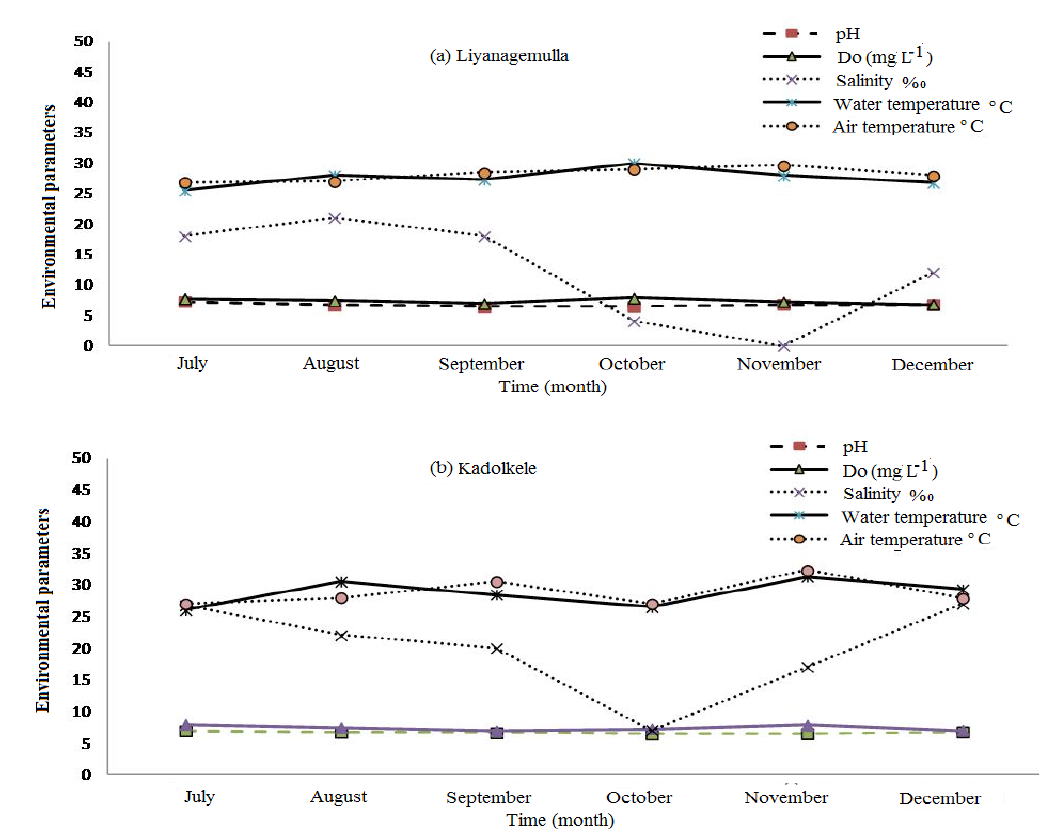
Figure 4: Monthly variation of environmental parameters, in study sites, (a) Liyanagemulla (b) Kadolkele. Table 6: Pearsons correlation coefficients (r) between mysid abundance and environmental Parameters. Water pH Do Salinity temperature